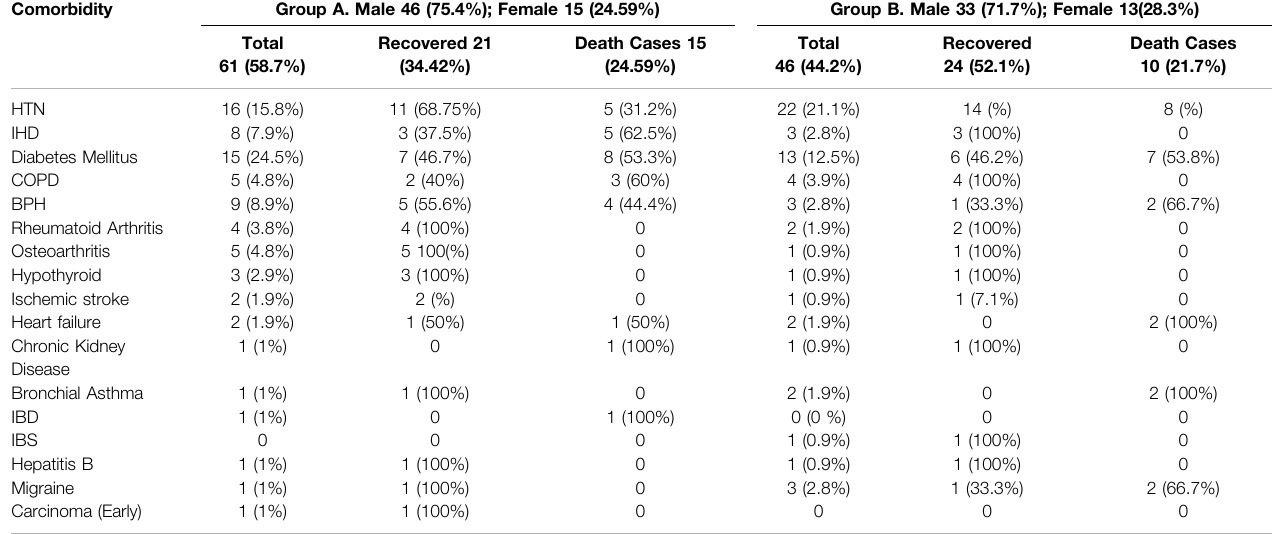
TABLE 6 | Distribution and analysis of comorbidity among the study group patients.